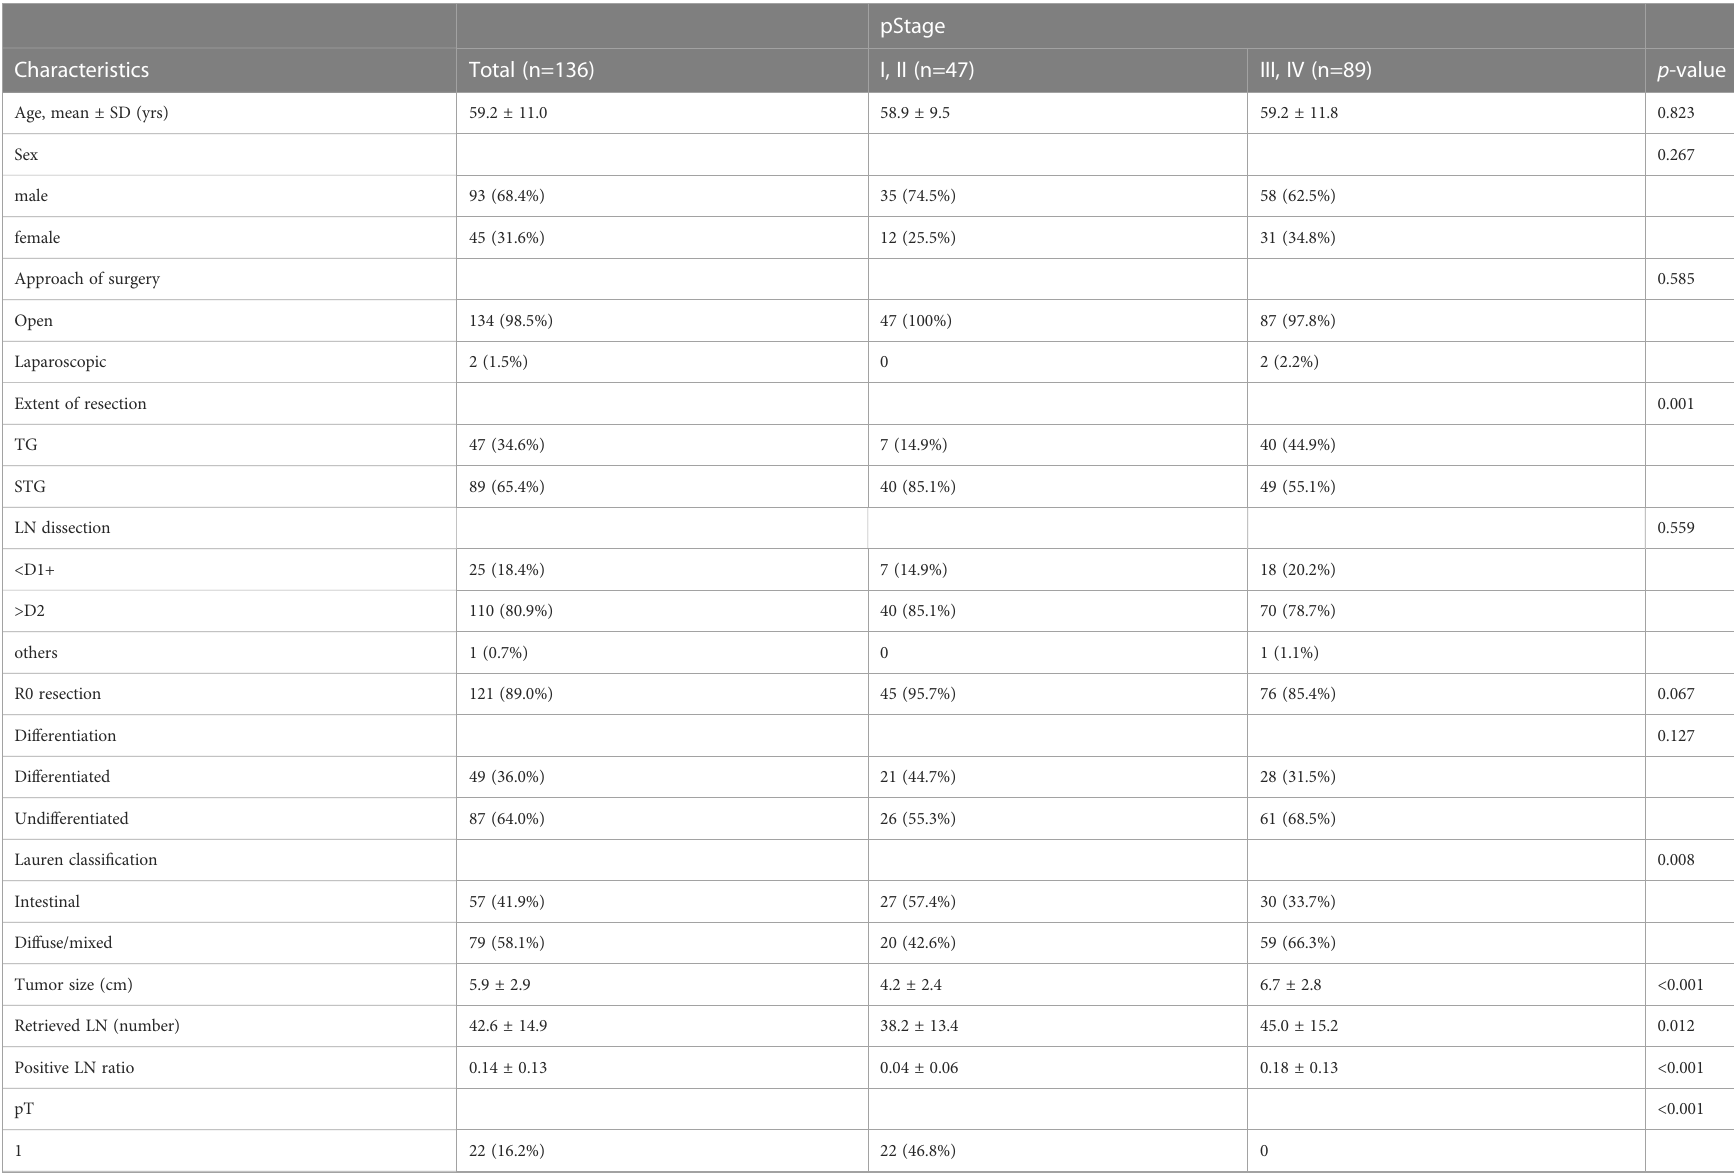
TABLE 1 Clinicopathologic characteristics of patients with gastric cancer according to